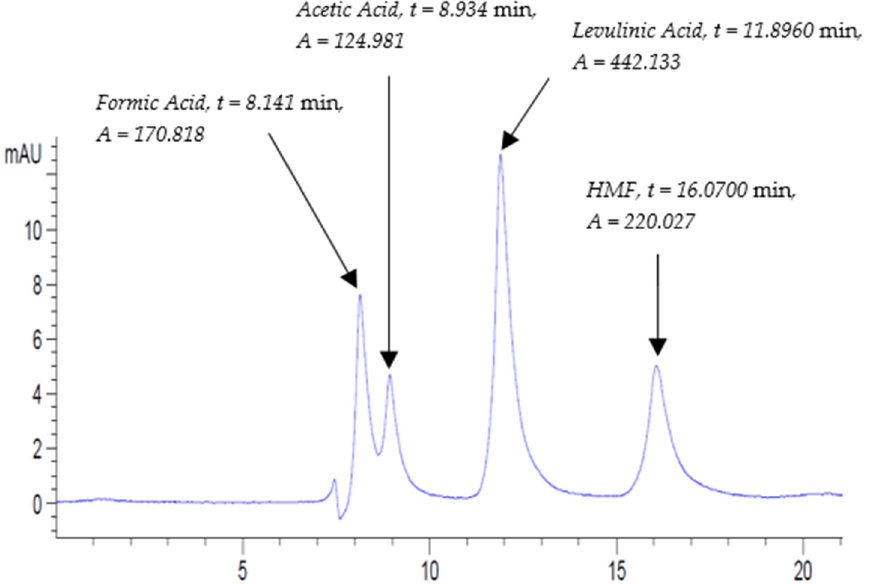
Figure 5. Mixed standard solution STD4-Inline-ACV(A) chromatogram at UV-210 nm at the following conditions: flow rate, 0.3 mL/min; column temperature, 30 °C; and run time, 20 min.